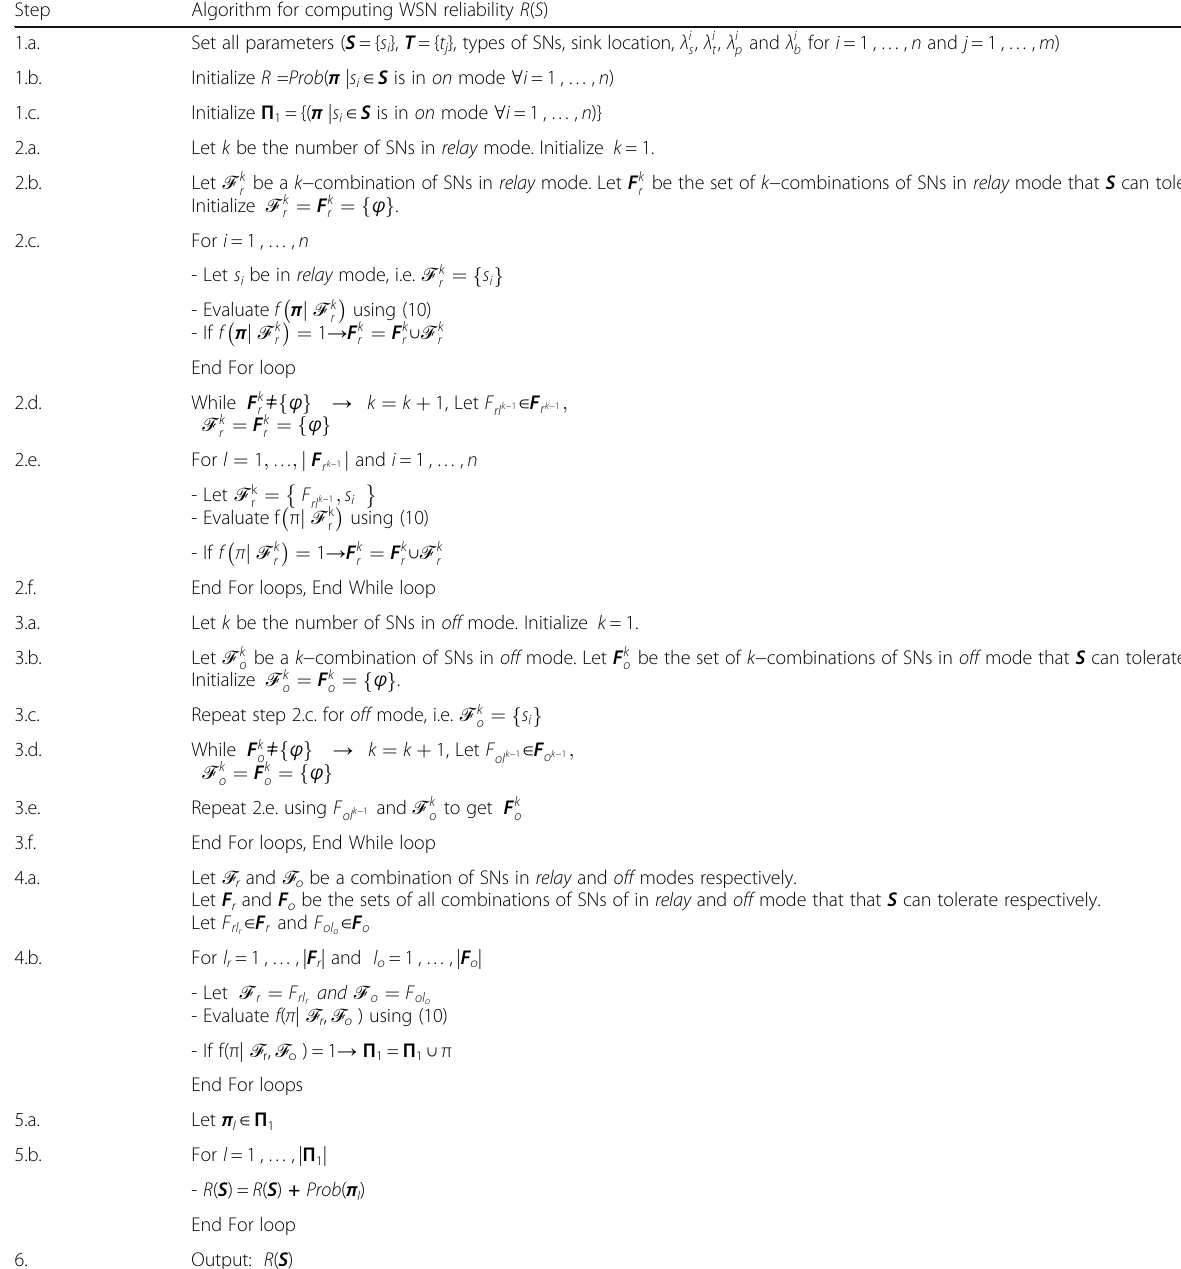
Table 2 Pseudo-code for the proposed algorithm for calculating the reliability of a WSN S Step Algorithm for computing WSN reliability R ( S